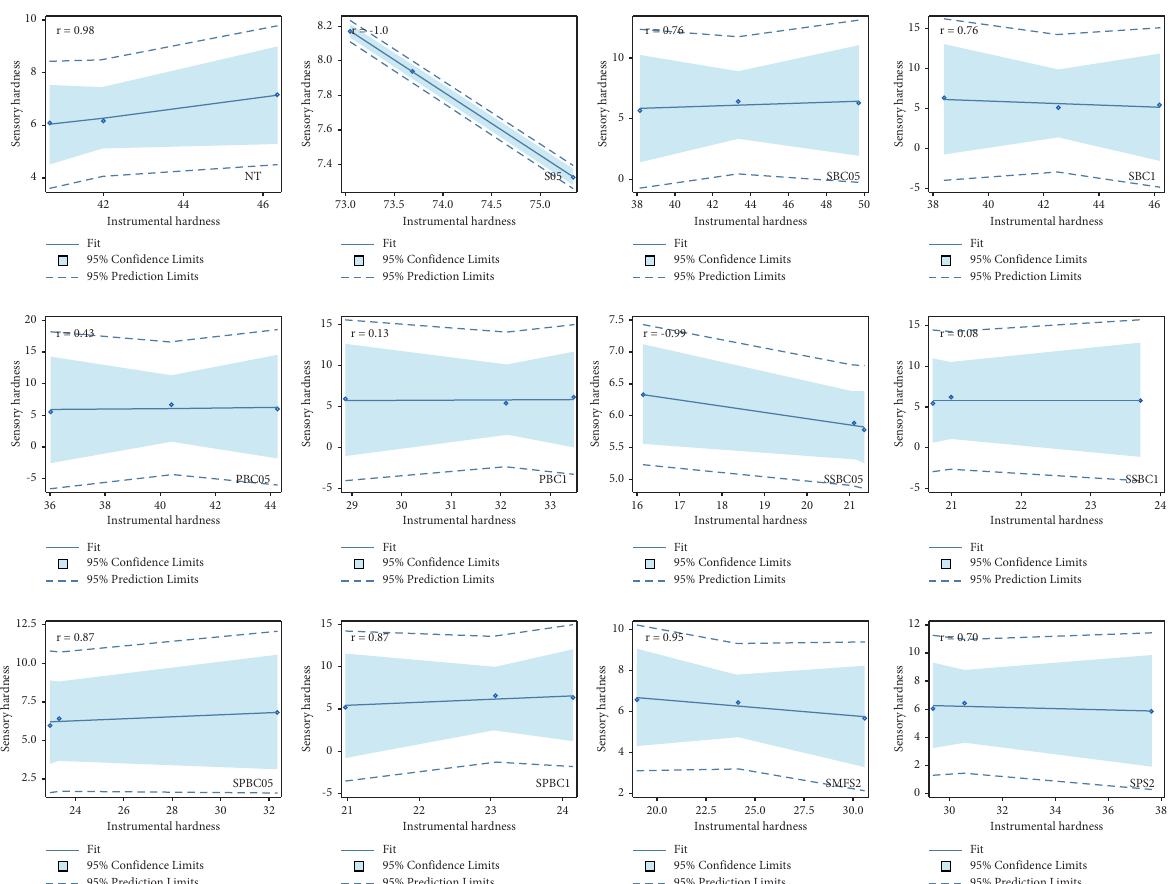
Figure 1: Scatter plot correlation matrix comparing the hardness sensory descriptive analysis and instrumental texture profile analysis of ground beef treated with different levels of sodium bicarbonate, potassium bicarbonate, salt, modified food starch, and potato starch. Control: NT; salt (0.5%): S05; sodium bicarbonate (0.5%): SBC05; sodium bicarbonate (1.0%): SBC1; potassium bicarbonate (0.5%): PBS05; potassium bicarbonate (1.0%): PBC1; sodium bicarbonate+salt (0.5%+ 0.5%): SSBC05; sodium bicarbonate+salt (1.0% +0.5%): SSBC1; potassium bicarbonate+salt (0.5% +0.5%): SPBC05; potassium bicarbonate+salt (1.0% +0.5%): SPBC1; modified food starch +salt (2.0%+0.5%): SMSF2; potato starch +salt (2.0% +0.5%):